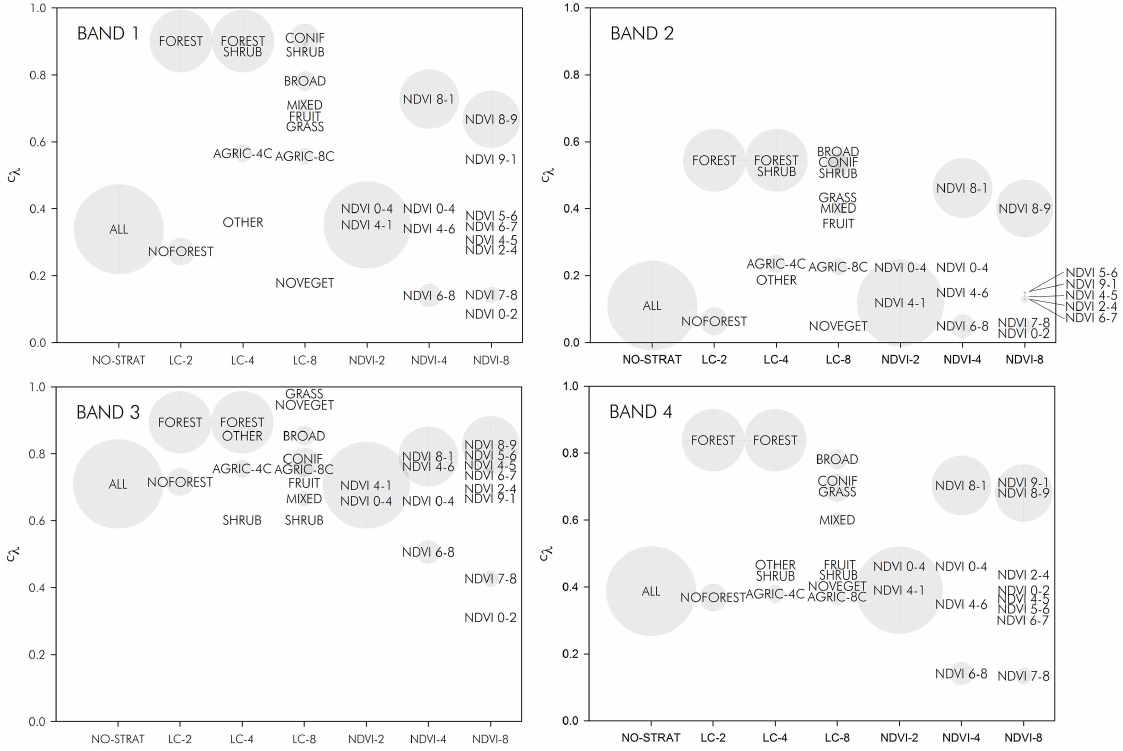
Figure 3. c λ coefficient obtained for each spectral band on the different stratification approaches evaluated. Circle sizes represent the proportion of each stratum in the study